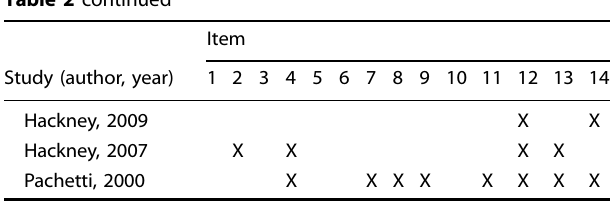
Table 2. Quality assessment within studies per